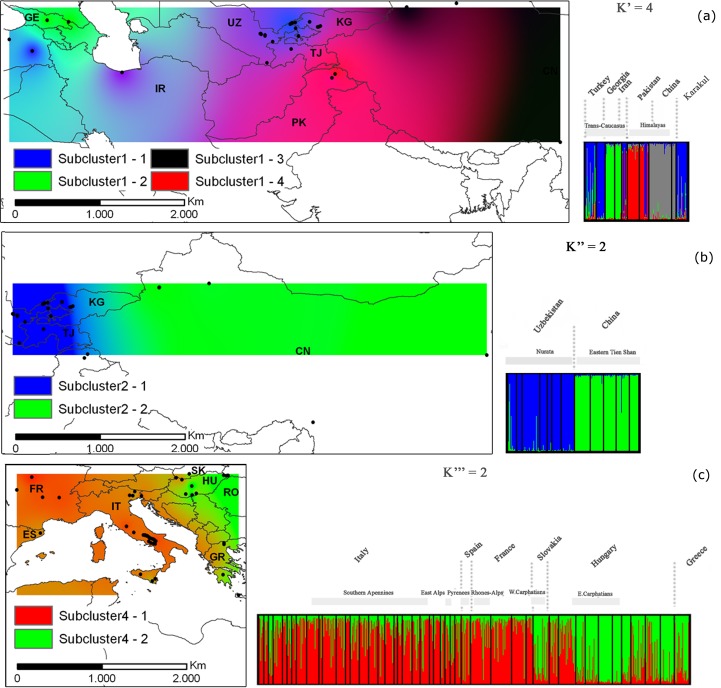
Spatial genetic sub-structure of the inferred clusters 1, 2 and 4 of walnut populations.Synthetic maps of Inverse Distance Weighted (IDW) interpolations of the estimated mean population membership values (Qi) and bar plot for (a) K’, the most probable number of sub-clusters, based on microsatellite analysis of 217 walnut samples of cluster 1, (b) for K”, the most probable number of sub-clusters, based on microsatellite analysis of 280 walnut samples of cluster 2 and (c) for K”‘ the most probable number of sub-clusters, based on microsatellite analysis of 929 walnut samples of cluster 4.